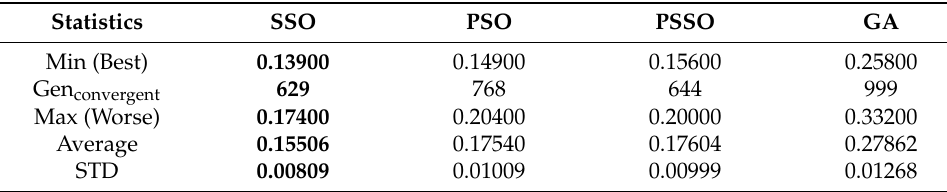
Table 11. The statistics of running time (units used: seconds) for benchmark